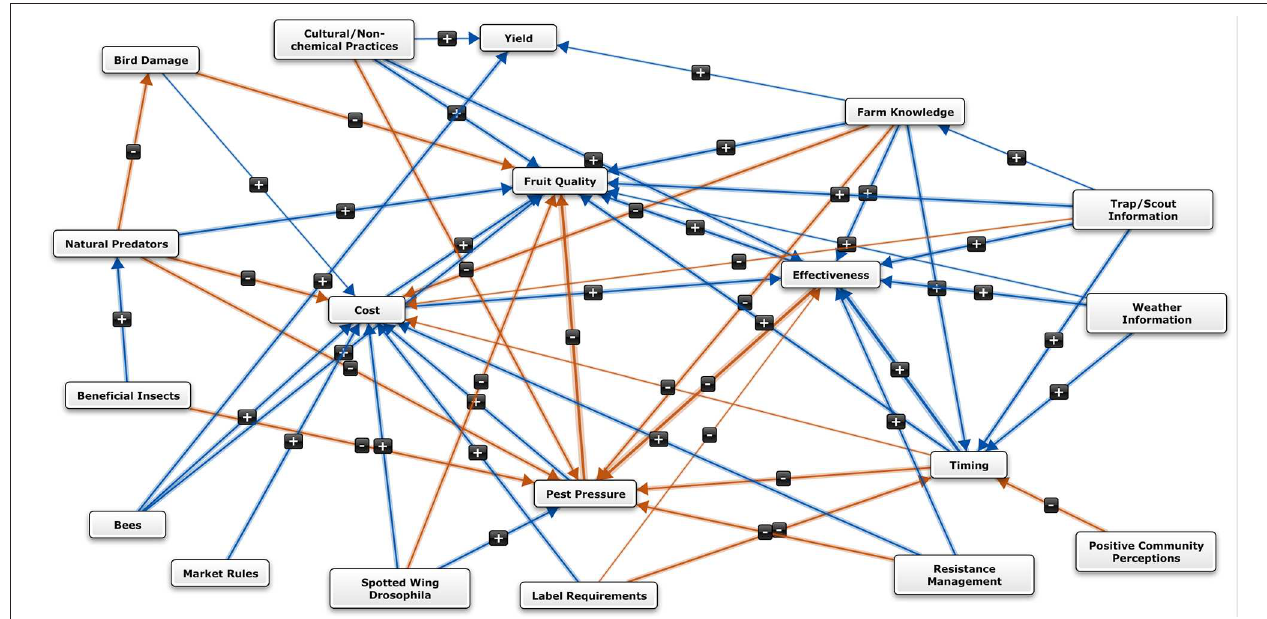
FIGURE 2 | Group map for farmers who included both natural predators and beneficial insects in their map. The blue lines indicate a positive relationship (if A increases, so does B) and the red lines indicate a negative relationship (if A increases, B decreases). The thickness of the line indicates the average strength of the relationship for the group of farmers, with thicker lines representing stronger effects, and thin lines representing lighter effects. The arrow indicated the direction of the relationship (A affects B).